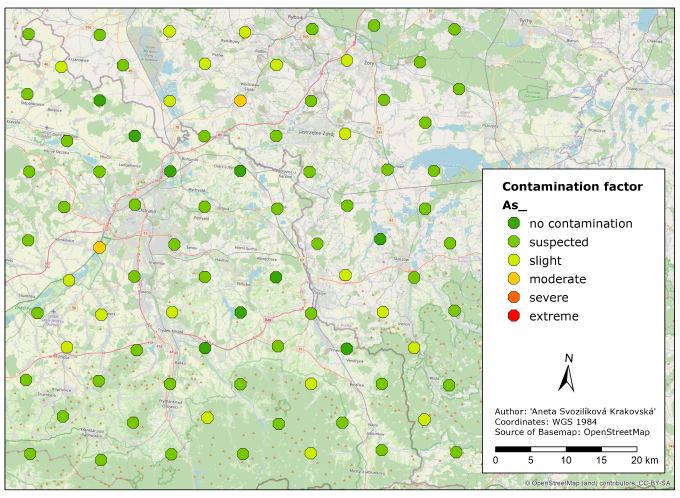
Figure 13. The distribution of values of the contamination factor for